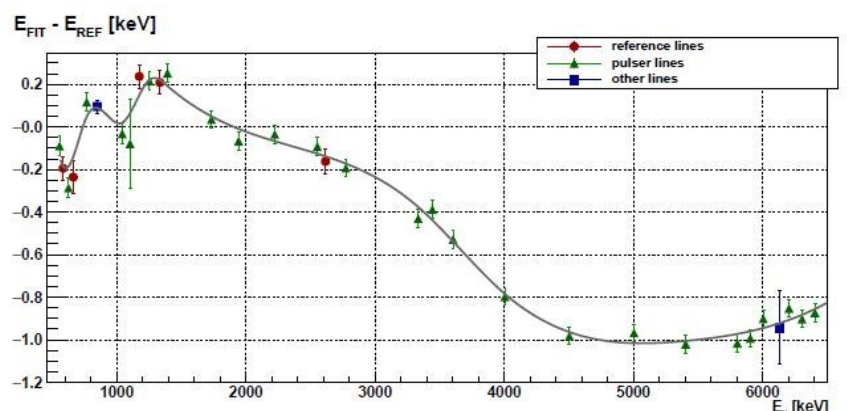
Figure 2: The energy scale calibration for HPGe detector. The red dots are obtained from the radiation sources, the green triangles are from pulser peaks in the spectrum, the blue squares are used for calibration check.